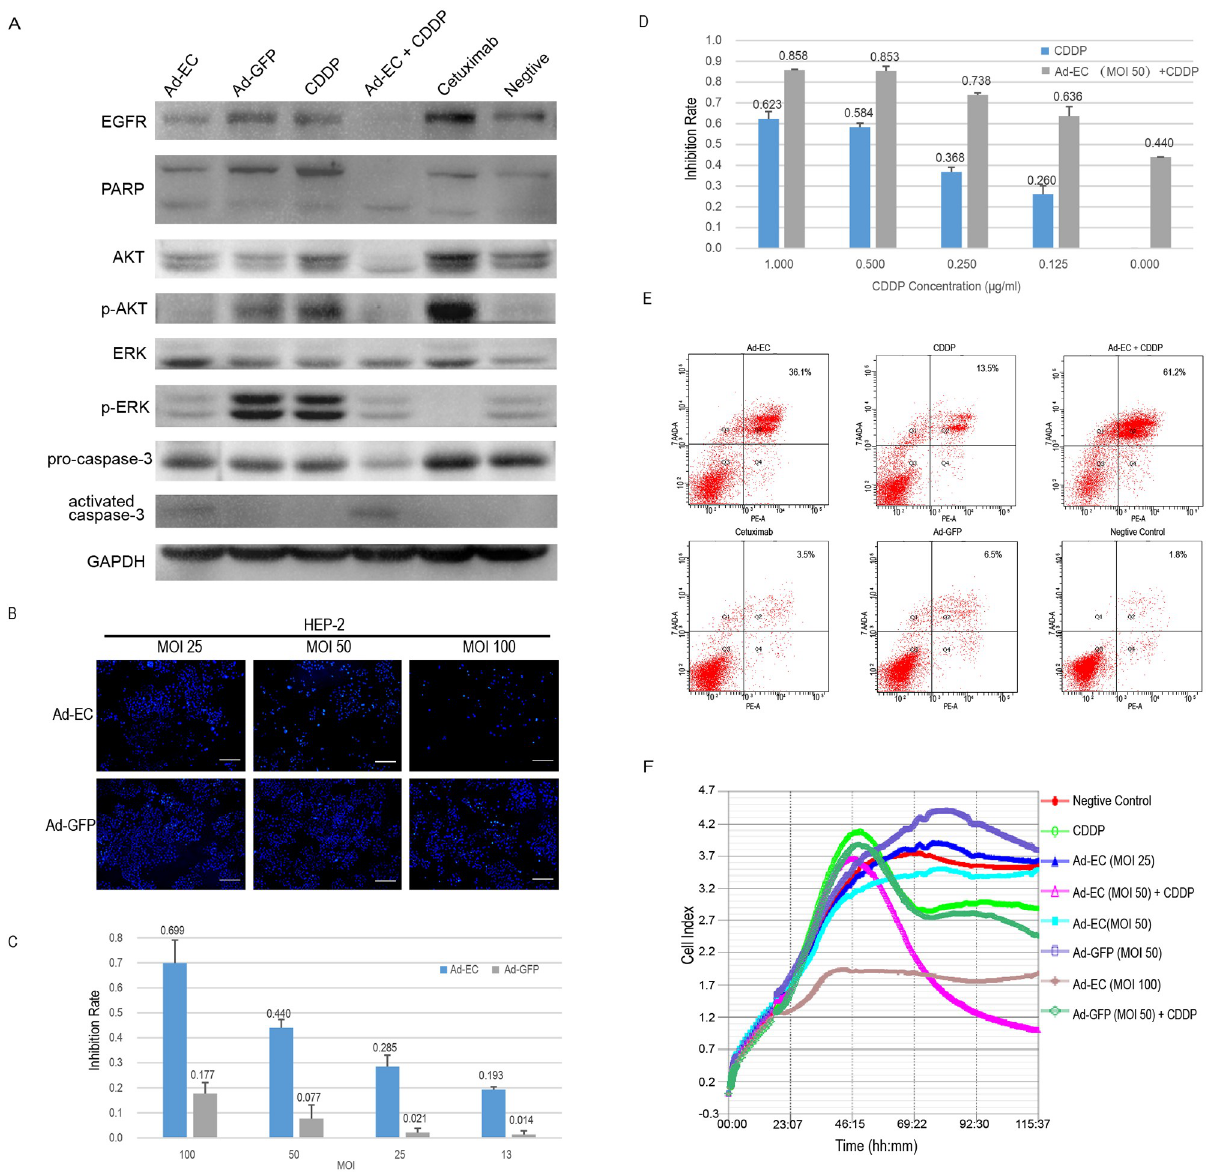
Fig 3. Efficient inhibition of HEP-2 cells in vitro by Ad-EC via inducing apoptosis. (A) HEP-2 cells were treated as follow: Ad-EC (MOI 50), CDDP (0.25 μ g/ml), Ad-EC (MOI 50) combined with CDDP(0.25 μ g/ml), Cetuximab(500 μ g/ml), Ad-GFP (MOI 50) or PBS. After incubating for 72 h, cells were harvested to detect the expression of following protein by Western blotting: EGFR, PARP, AKT, phosphorylated AKT, ERK, phosphorylated ERK, pro-caspase-3, activated caspase-3, and GAPDH as a control. (B) 4 0 6-diamidino-2-phenylindole (DAPI) staining was performed in HEP-2 cells after a 72 h infection of Ad-EC and Ad-GFP (MOI 25, 50, and 100). Bar = 200 μ m. (C) HEP-2 cells were infected with Ad-EC and Ad-GFP (MOI 13, 25, 50, and 100) for 72 h and assayed by MTT assay. (D) HEP-2 cells were treated with Ad-EC (MOI 50) in combination with different concentrations of CDDP (0.125. 0.25. 0.5 and 1 μ g/ml) for 72 h and assayed by MTT. (E) HEP-2 cells were treated in the same way as in Western blot. Apoptosis was analyzed using Annexin V/7-aminoactinomycin D (7-AAD) double-staining followed by flow cytometry after treatments. The upper right quadrant of the histograms indicated late apoptosis cells. The rates of late apoptosis cells were labeled in each group. (F) The xCELLigence proliferation assay recorded the real-time HEP-2 cell growth during the 96 h exposure of Ad-EC (MOI 25, 50, and 100), Ad-GFP (MOI 50), CDDP (0.25 μ g/ml), Ad-EC (MOI 50) combined with CDDP (0.25 μ g/ml), Ad-GFP (MOI 50) combined with CDDP (0.25 μ g/ml), or PBS. The cell index (CI) value is proportional to the number of living wall-attached cells before cell overgrowth.